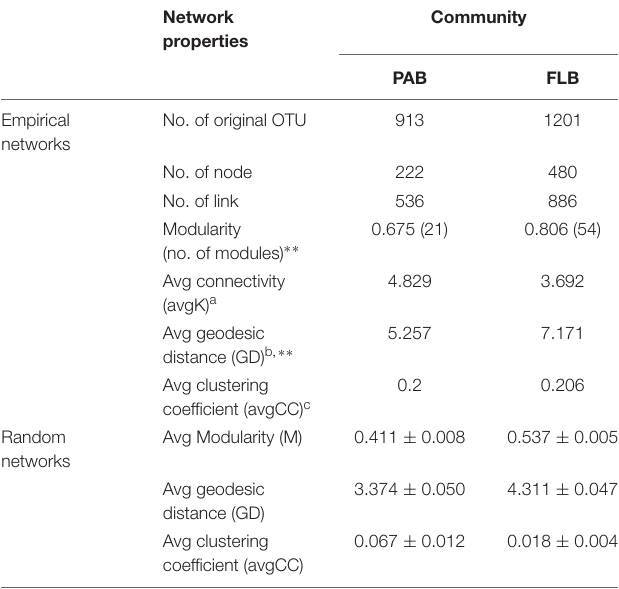
TABLE 3 | Major topological properties of empirical and random MENs of PAB and